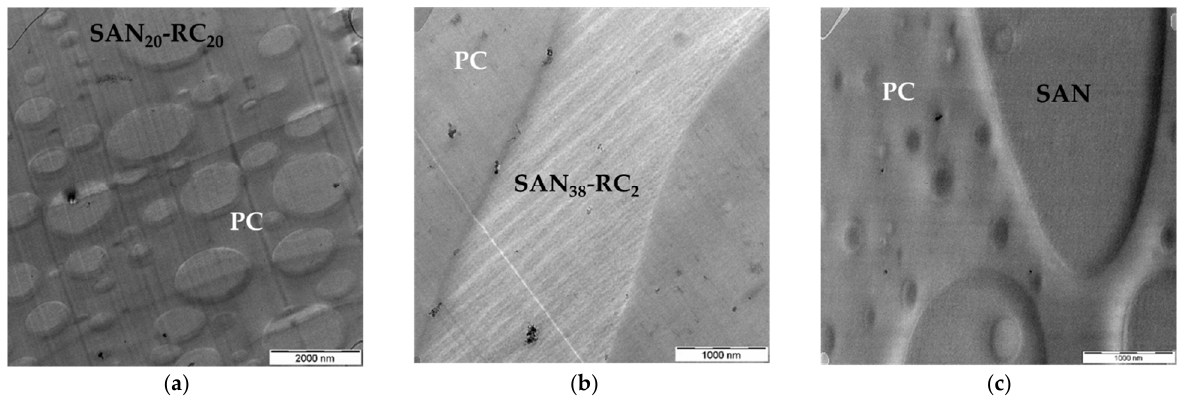
Figure 5. TEM images of SWeNT ® SWCNT filled PC 60 /SAN 40-x -RC x blends: ( a ) PC 60 /SAN 20 -RC 20 blends and ( b ) PC 60 /SAN 38 -RC 2 blends showing SWeNT ® (0.5 wt. %) localized in both components and ( c ) in PC 60 /SAN 40 blends SWeNT ® (0.5 wt. %) remain in PC.